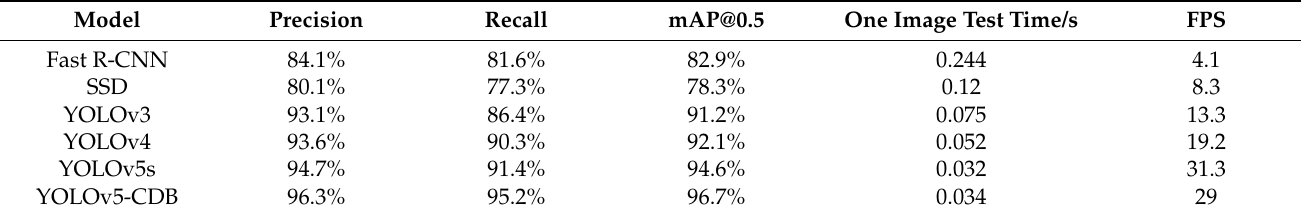
Table 4. Performance comparison results of different algorithms.